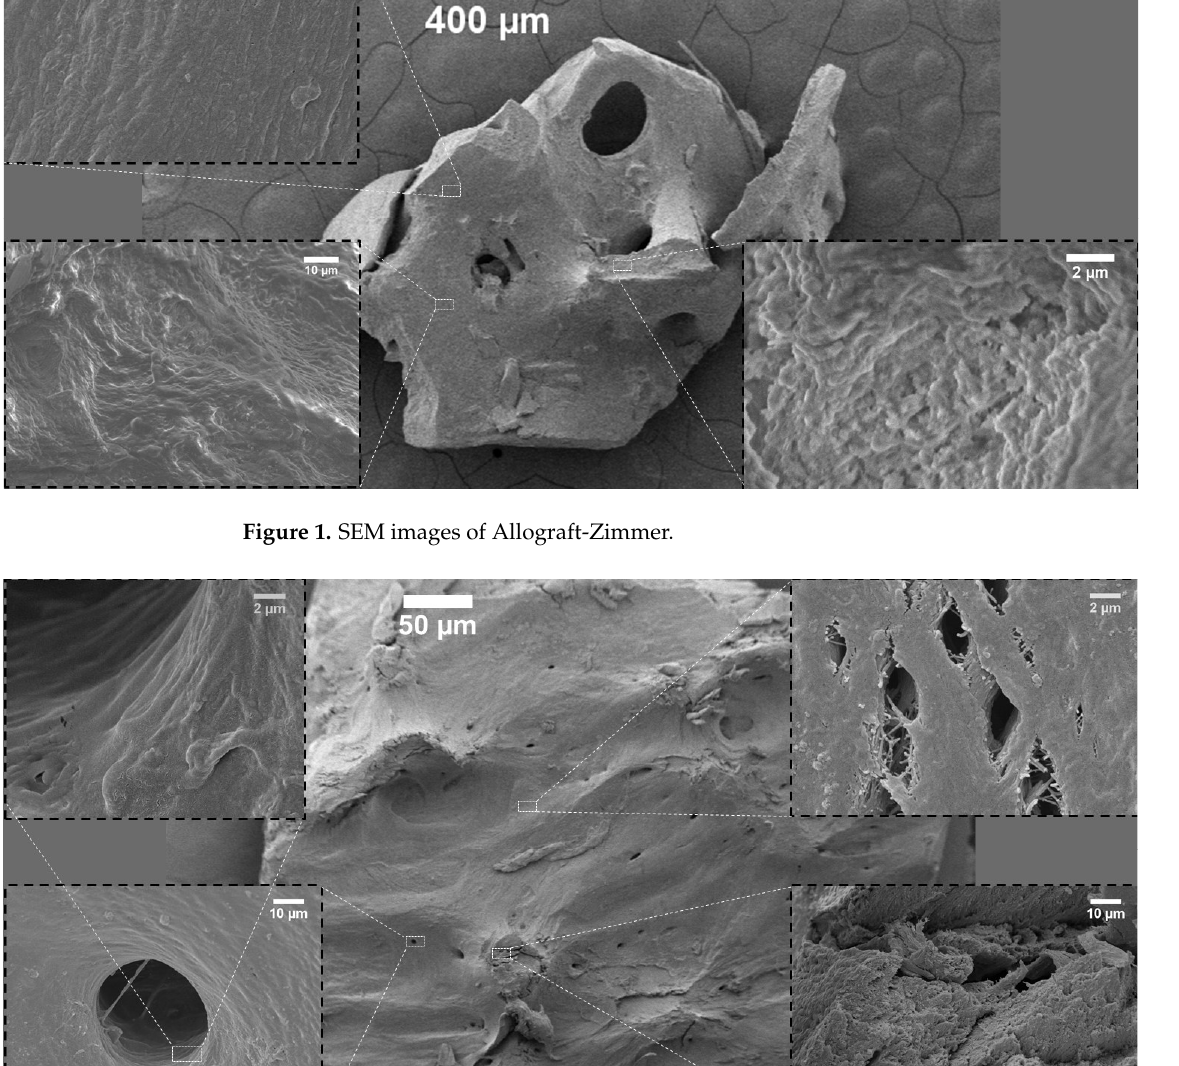
Figure 3. SEM images of Allograft-Biobank. Figure 4 presents parts of Processed-Tooth. After the preparation process, irregular particles with an average size in the range of 130–600 µm were found. Across the surface there were gouges and grooves, probably formatted during the preparation by Kometa- Bio (see the insert on the left-hand side of Figure 4). Contrary to allograft-materials, on the surface of Processed-Tooth, asymmetric spherical-like shapes were formed. The surface showed high porosity.